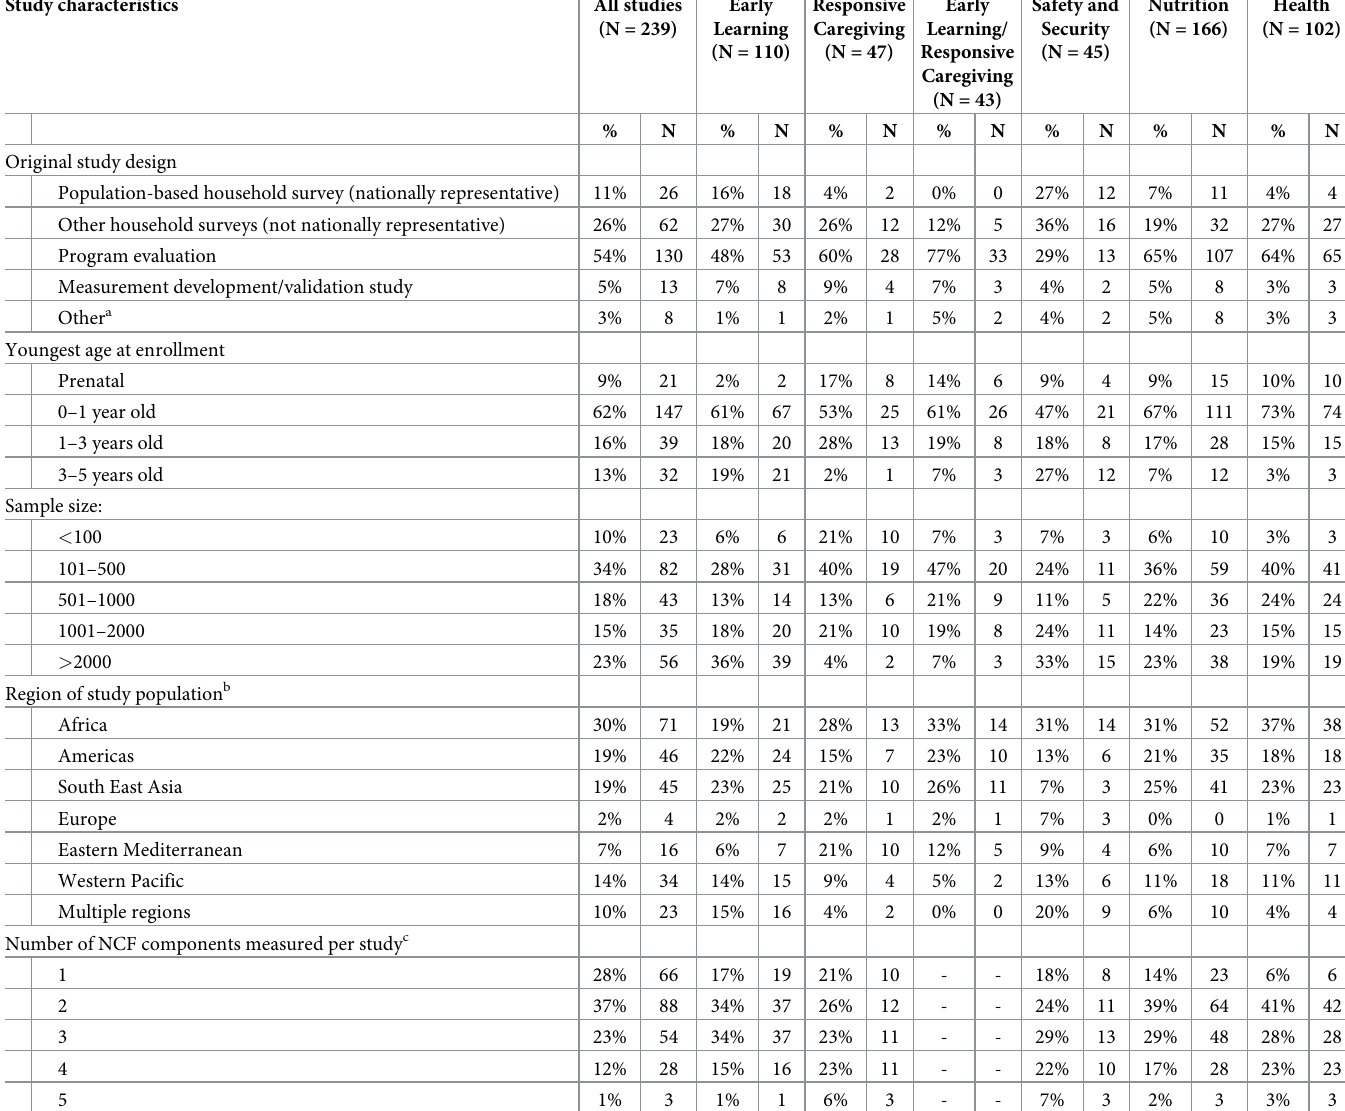
Table 1. Overview of study characteristics, by components of nurturing care indicators